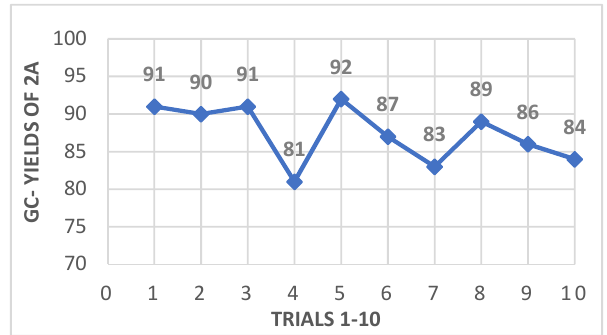
Figure 3. Recyclability studies.